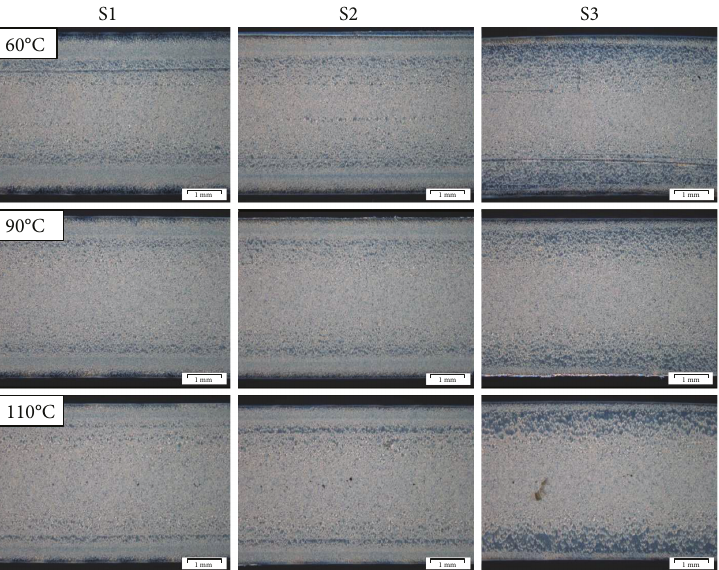
Figure 9: PLM images of the cross section of injection-molded Tenac plates in dependence on the distance from the sprue and on the mold temperature